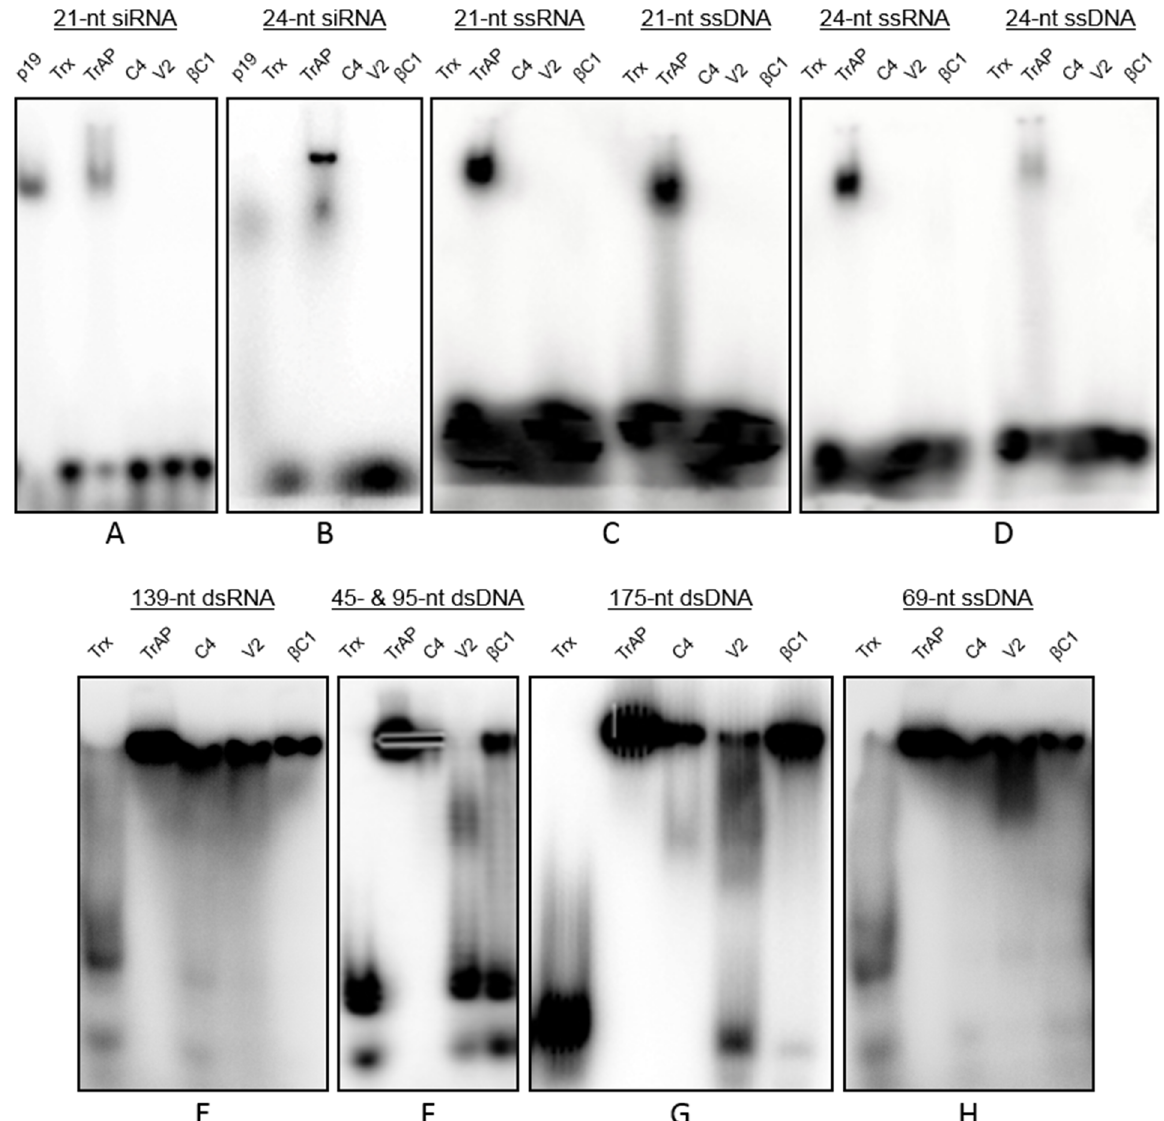
Figure 3. Electrophoretic mobility-shift assays of recombinant Trx-His tagged proteins. In each case, the nucleic acids used in the mobility-shift assays are indicated over the respective